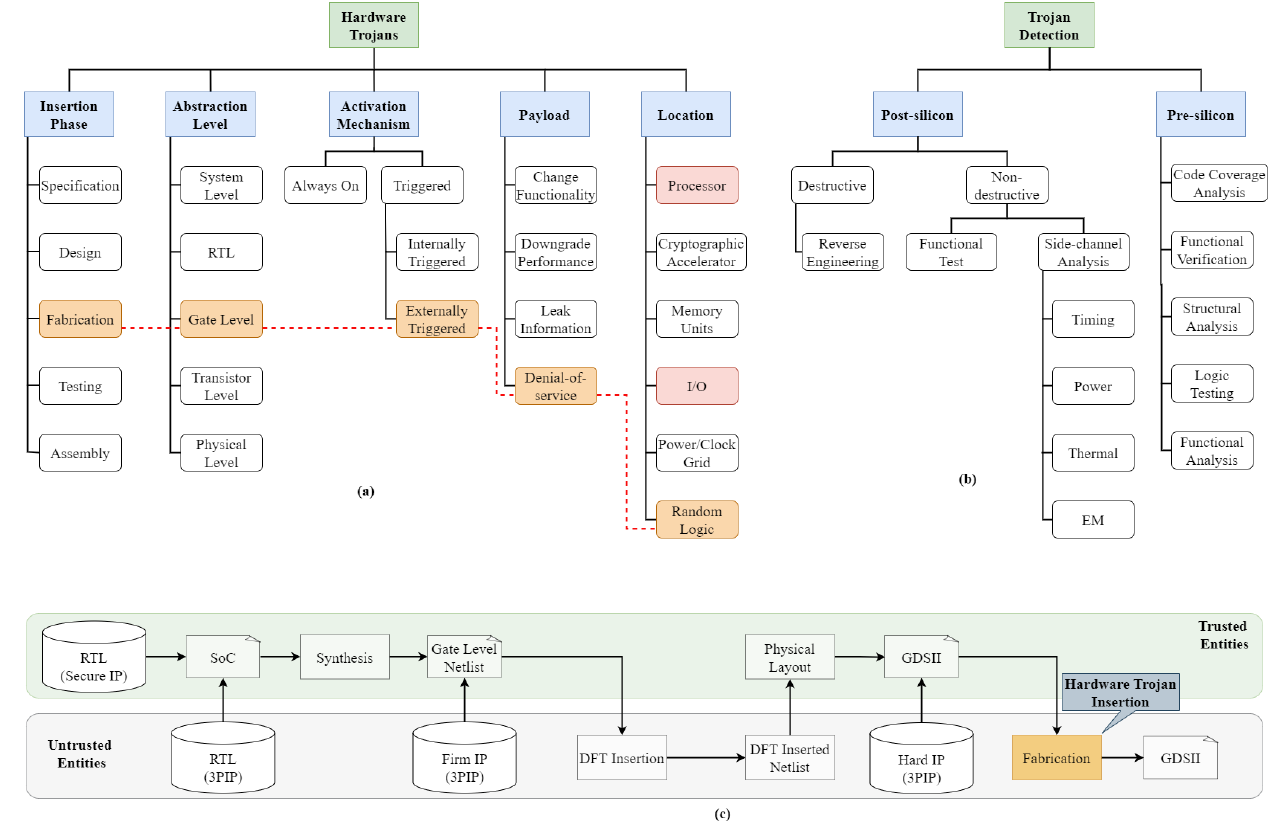
Figure 1. ( a ) Taxonomy of hardware Trojans and selected flow for this work. ( b ) Taxonomy of hardware Trojan detection. ( c ) System-on-chip (SoC) design